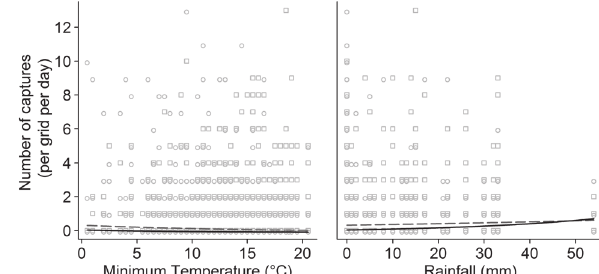
Figure 8. Graphical representation of the interactions between trap type (pitfall traps: circles; Sherman traps: squares) and rainfall or minimum temperature in determining the number of captures. Overlapping dots are horizontally scattered to improve visualiza- tion. Expected means for each trap type and rainfall or minimum temperature estimated from the best model in Table 3 (solid line: pitfall traps; dashed line: Sherman